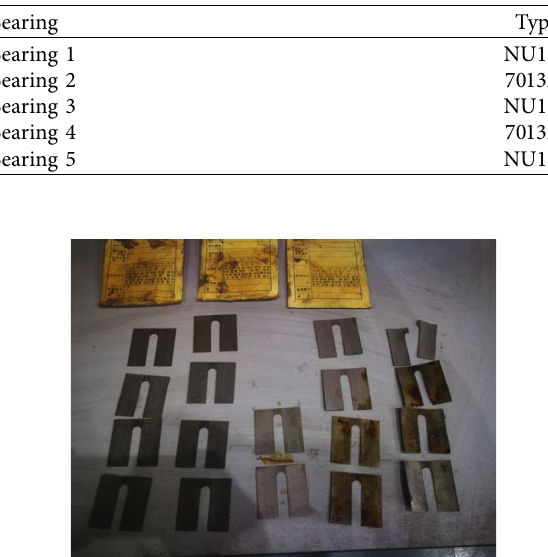
Figure 22: Gaskets of different